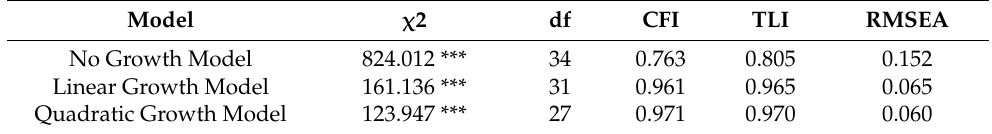
Table 2. Model Fit of the Unconditional Model.